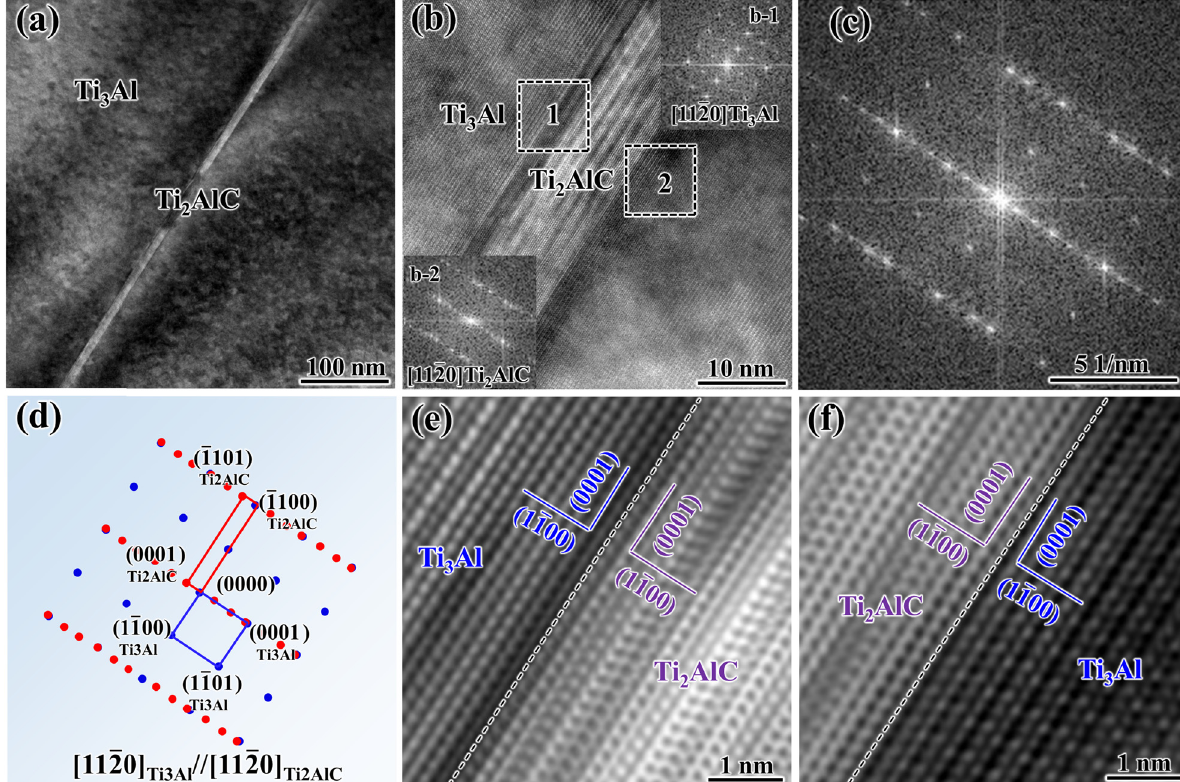
Figure 4: The TEM analysis of rod - like Ti 2 AlC nano - precipitate in Ti 3 Al: ( a ) TEM image of Ti 2 AlC in Ti 3 Al; ( b ) HRTEM image of the Ti 3 Al/Ti 2 AlC interface; ( c ) FFT pattern of the Ti ( d ) indexing of the FFT pattern in ( c ) ; and ( e and f ) IFFT images of the Ti 3 Al/Ti 2 AlC interface;